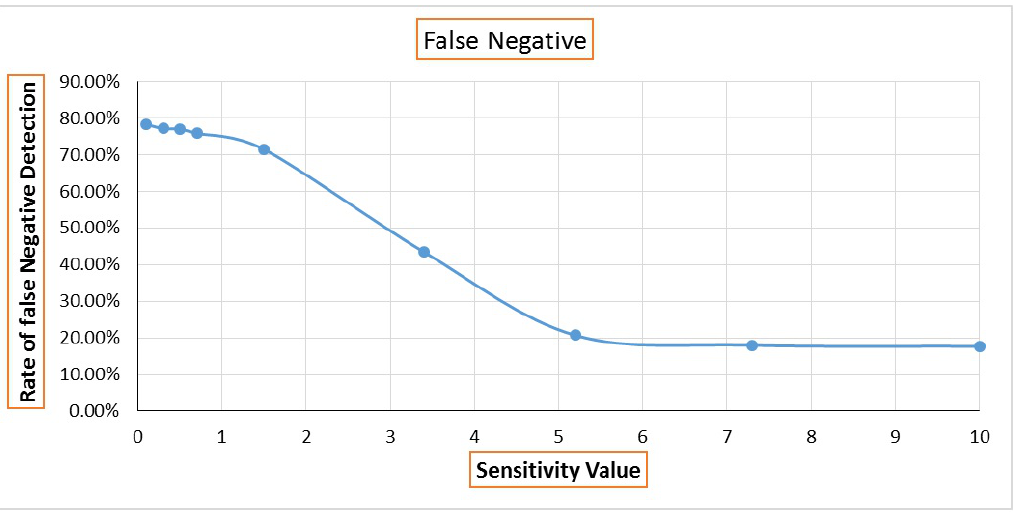
Figure 7. Overall false negative rate of Washington university image database with different sensitivity